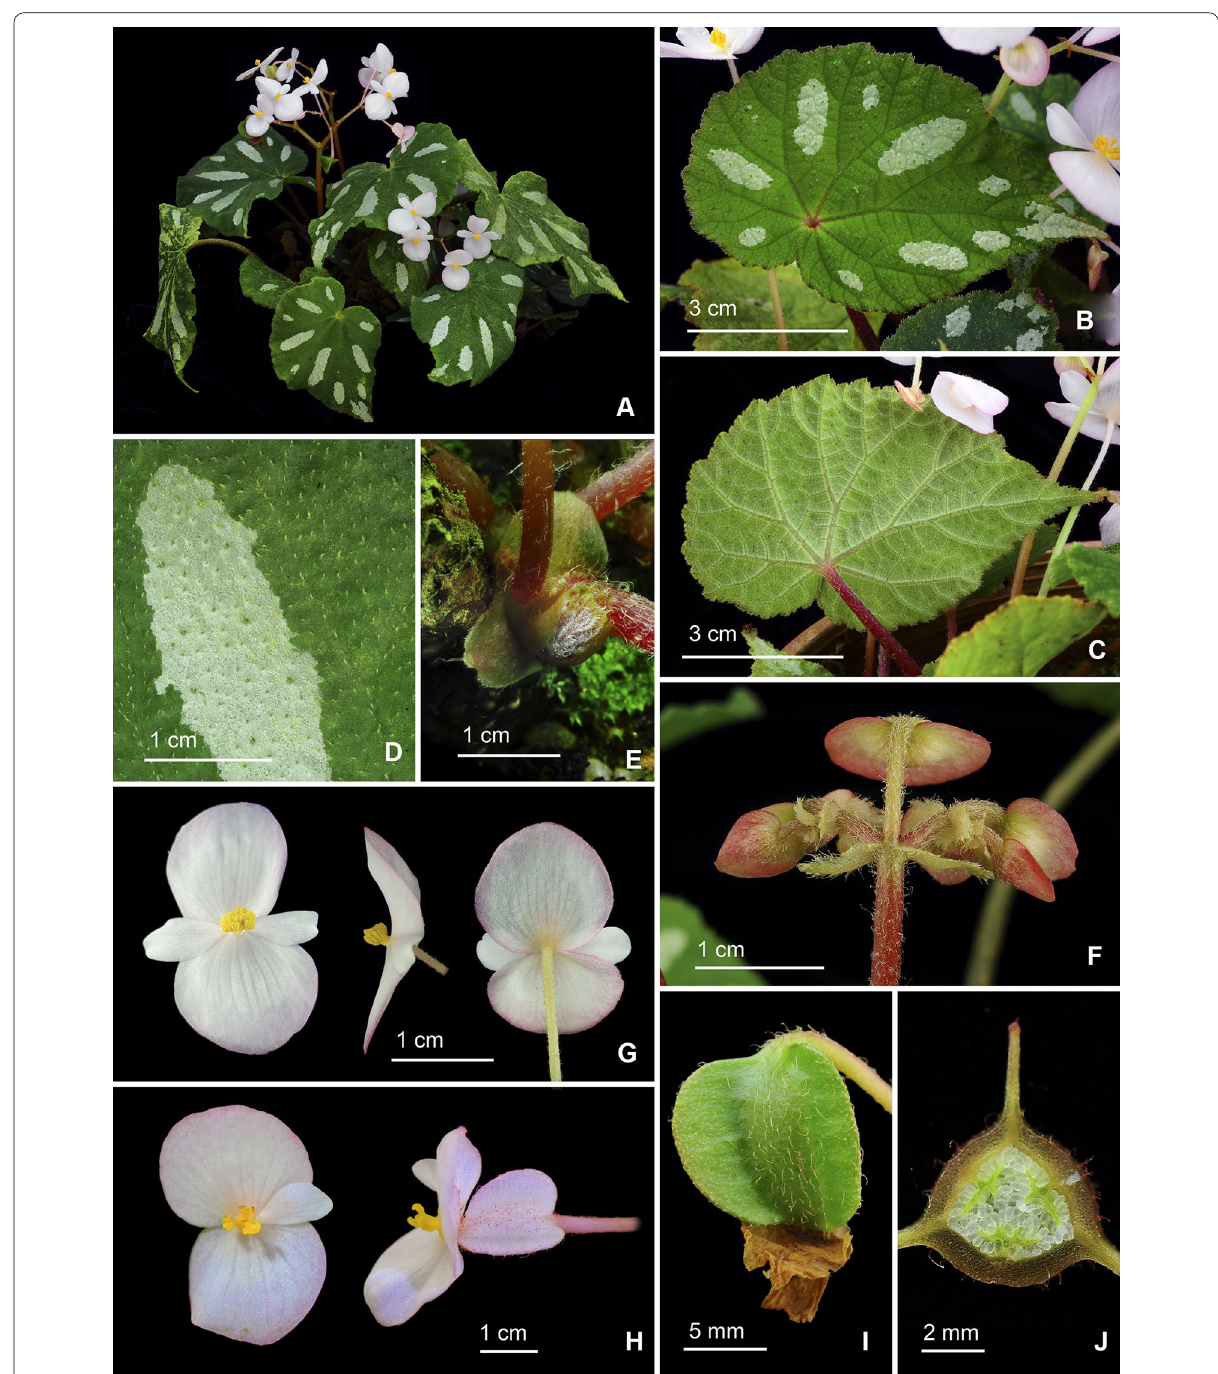
Fig. 13 Begonia scabrifolia C.I Peng, Yan Liu & C.W.Lin. A Cultivated plant at anthesis; B Leaf adaxial surface; C Leaf abaxial surface; D Leaf adaxial surface, showing indumentum; E Stipules; F Early stage of inflorescence, showing bracts; G Staminate flowers; H Pistillate flowers; I Fruit; J Cross section of ovary. All from Peng